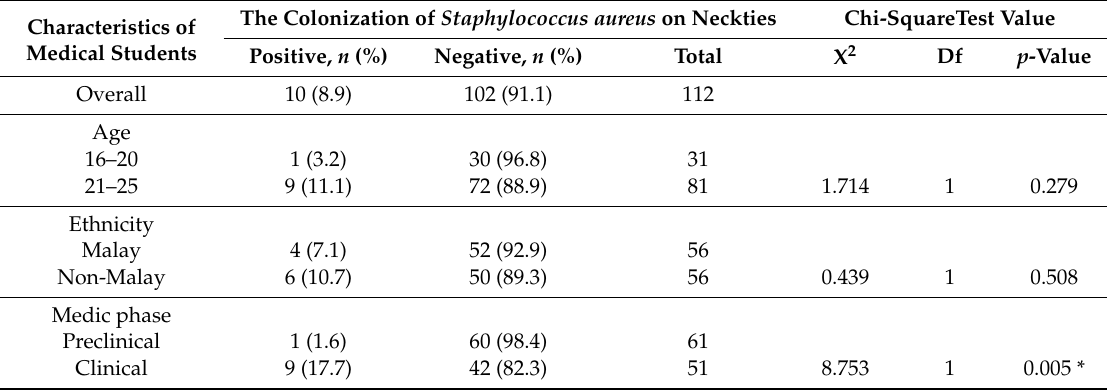
Table 3. Association of the socio-demographic characteristics of medical students with the colonization of S. aureus on neckties.